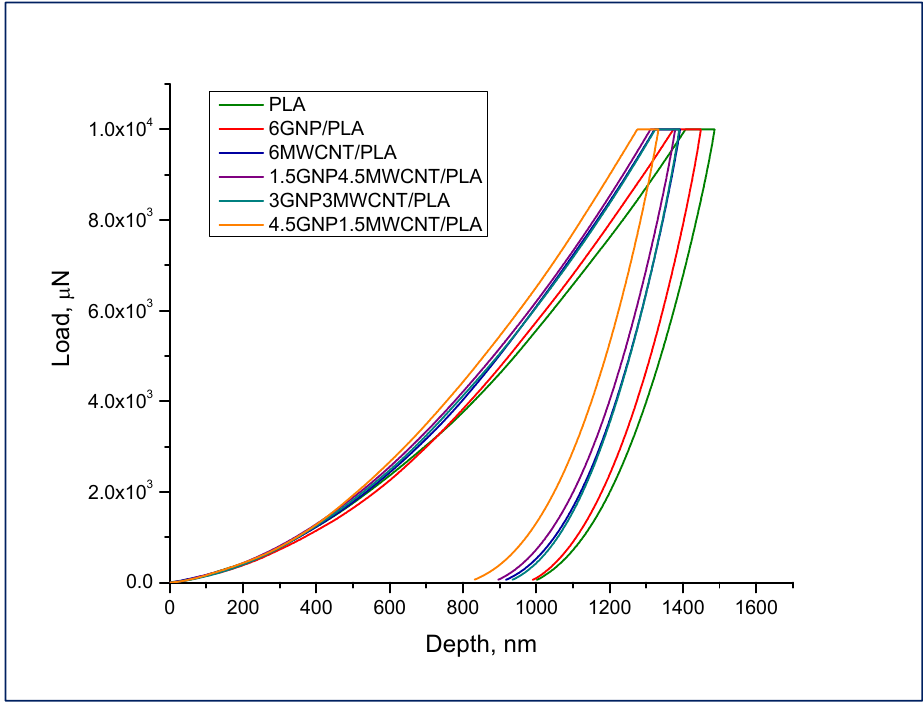
Figure 1. Nanoindentation curves of all composite specimens including pure PLA obtained at 10,000 μ N peak force.